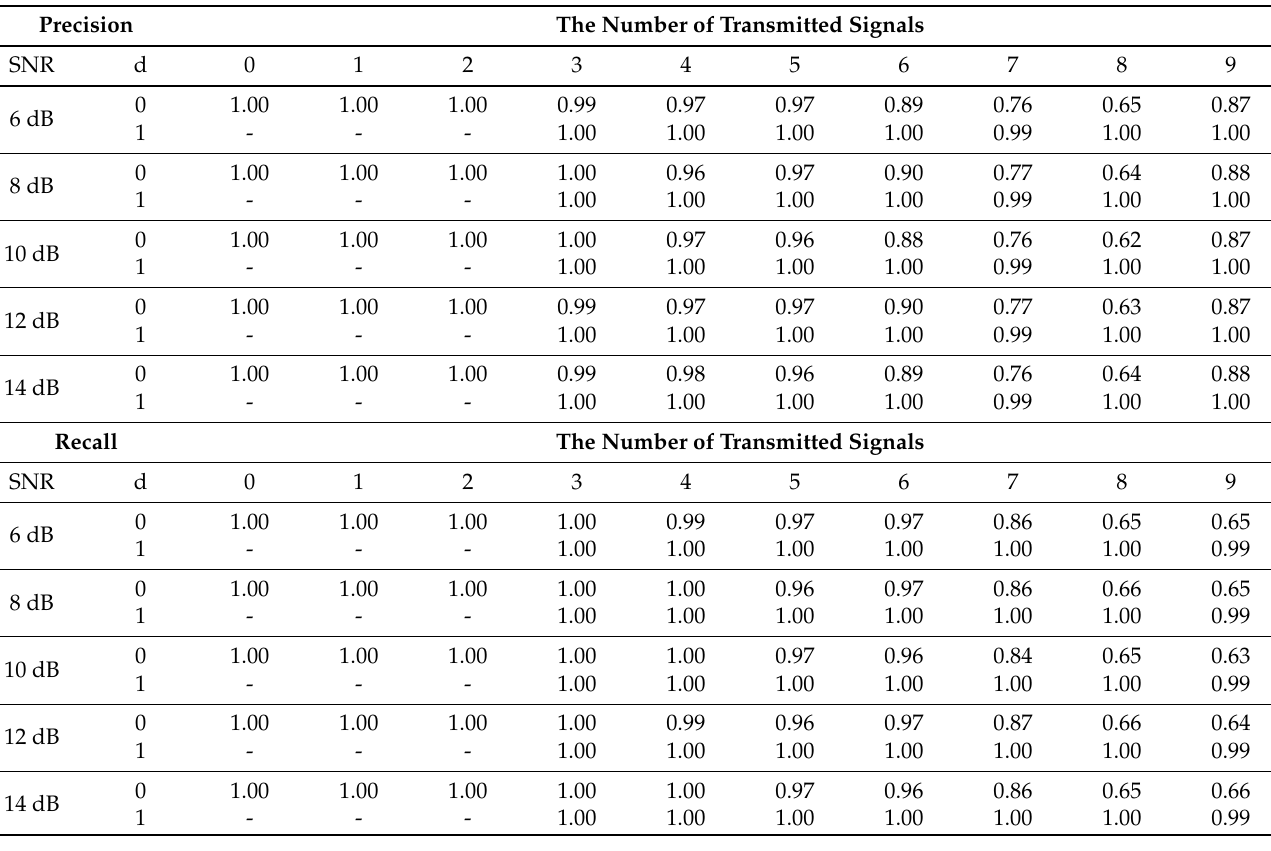
Table 3. Precision and recall of our